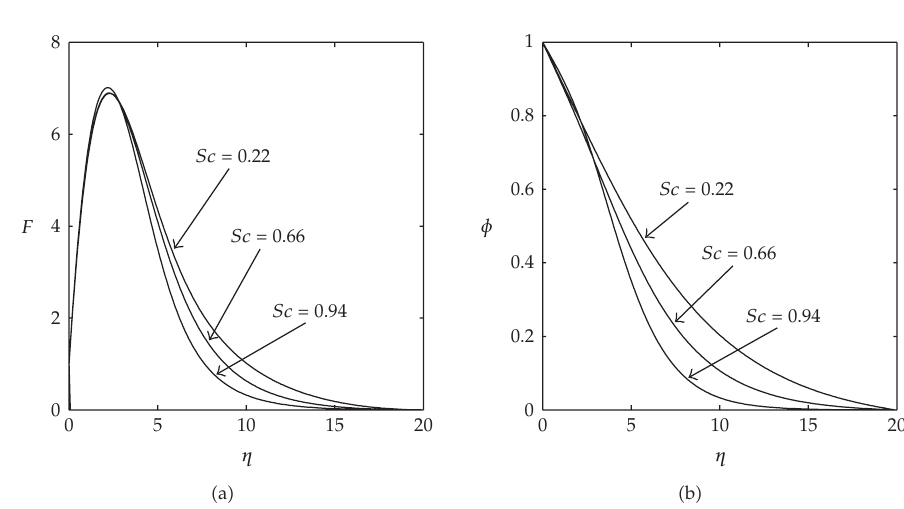
Figure 4: The variation of (cid:8) a (cid:9) the velocity and (cid:8) b (cid:9) the concentration profiles with di ff erent Schmidt numbers with ξ (cid:7) 5 , Gr (cid:7) Gr c (cid:7) 1 , Pr (cid:7) 0 . 72 , V 0 (cid:7) 0 . 1 , R (cid:7) 1 .